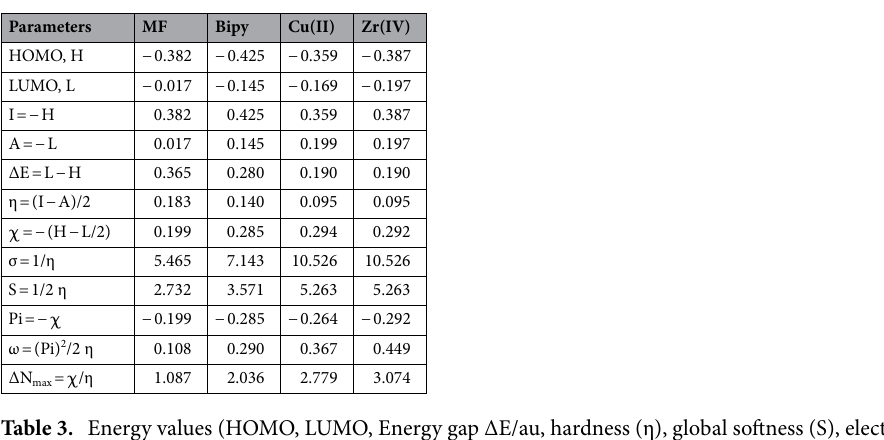
Table 3. Energy values (HOMO, LUMO, Energy gap ∆E/au, hardness (η), global softness (S), electronegativity ( χ ), absolute softness (σ), chemical potential (Pi), global electrophilicity (ω) and additional electronic charge (∆N max ) of the two ligands and studied complexes by using DFT calculations. (I) is ionization energy, (A) is an electron